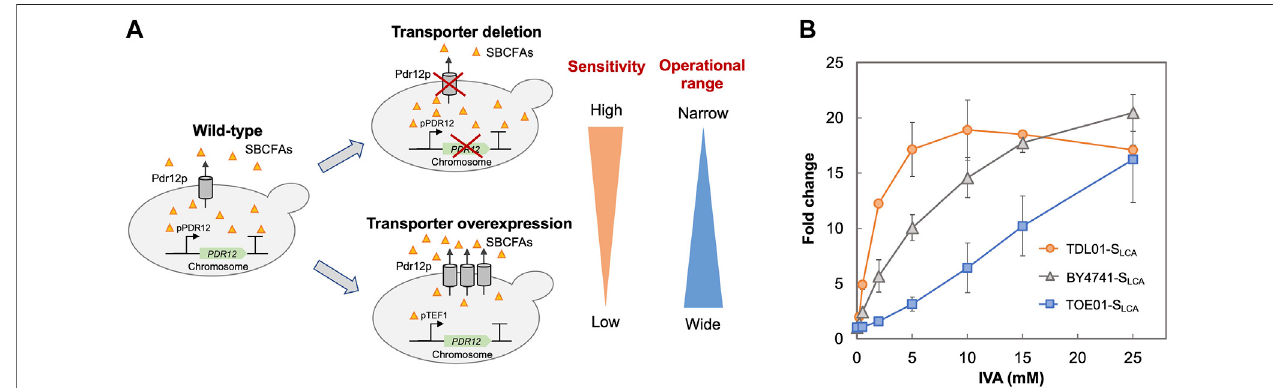
FIGURE 4 | Optimization of biosensor ’ s sensitivity and operational range. (A) Schematic presentation of strategies employed to optimize the biosensor. The ABC transporter Pdr12p is known to regulate the intracellular level of weak organic acids by export. To improve the biosensor ’ s sensitivity, an ABC transporter gene PDR12 was deleted to increase the intracellular SBCFA level (TDL-S LCA ), which will increase the fl uorescence. To extend the biosensor ’ s operational range, PDR12 was over- expressedunderthecontrolofastrongconstitutivepromoterpTEF1toreducetheintracellularSBCFAlevel(TOE-S LCA )throughSBCFAexport,whichwillenhance the SBCFA saturation level. (B) Dose-dependent responsesofbiosensors against IVA fed at 0.5, 2, 5, 10, and 25 mM. Their responses(fold change) were compared to